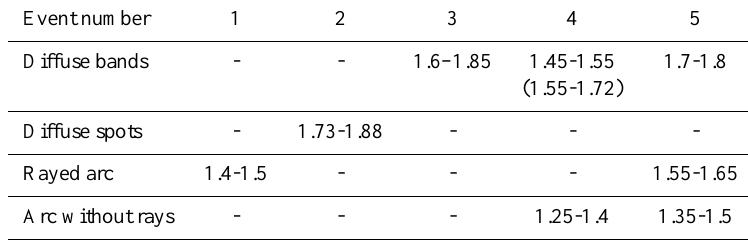
Table 1. Dimension of the most complex isoline for different auroral events Event